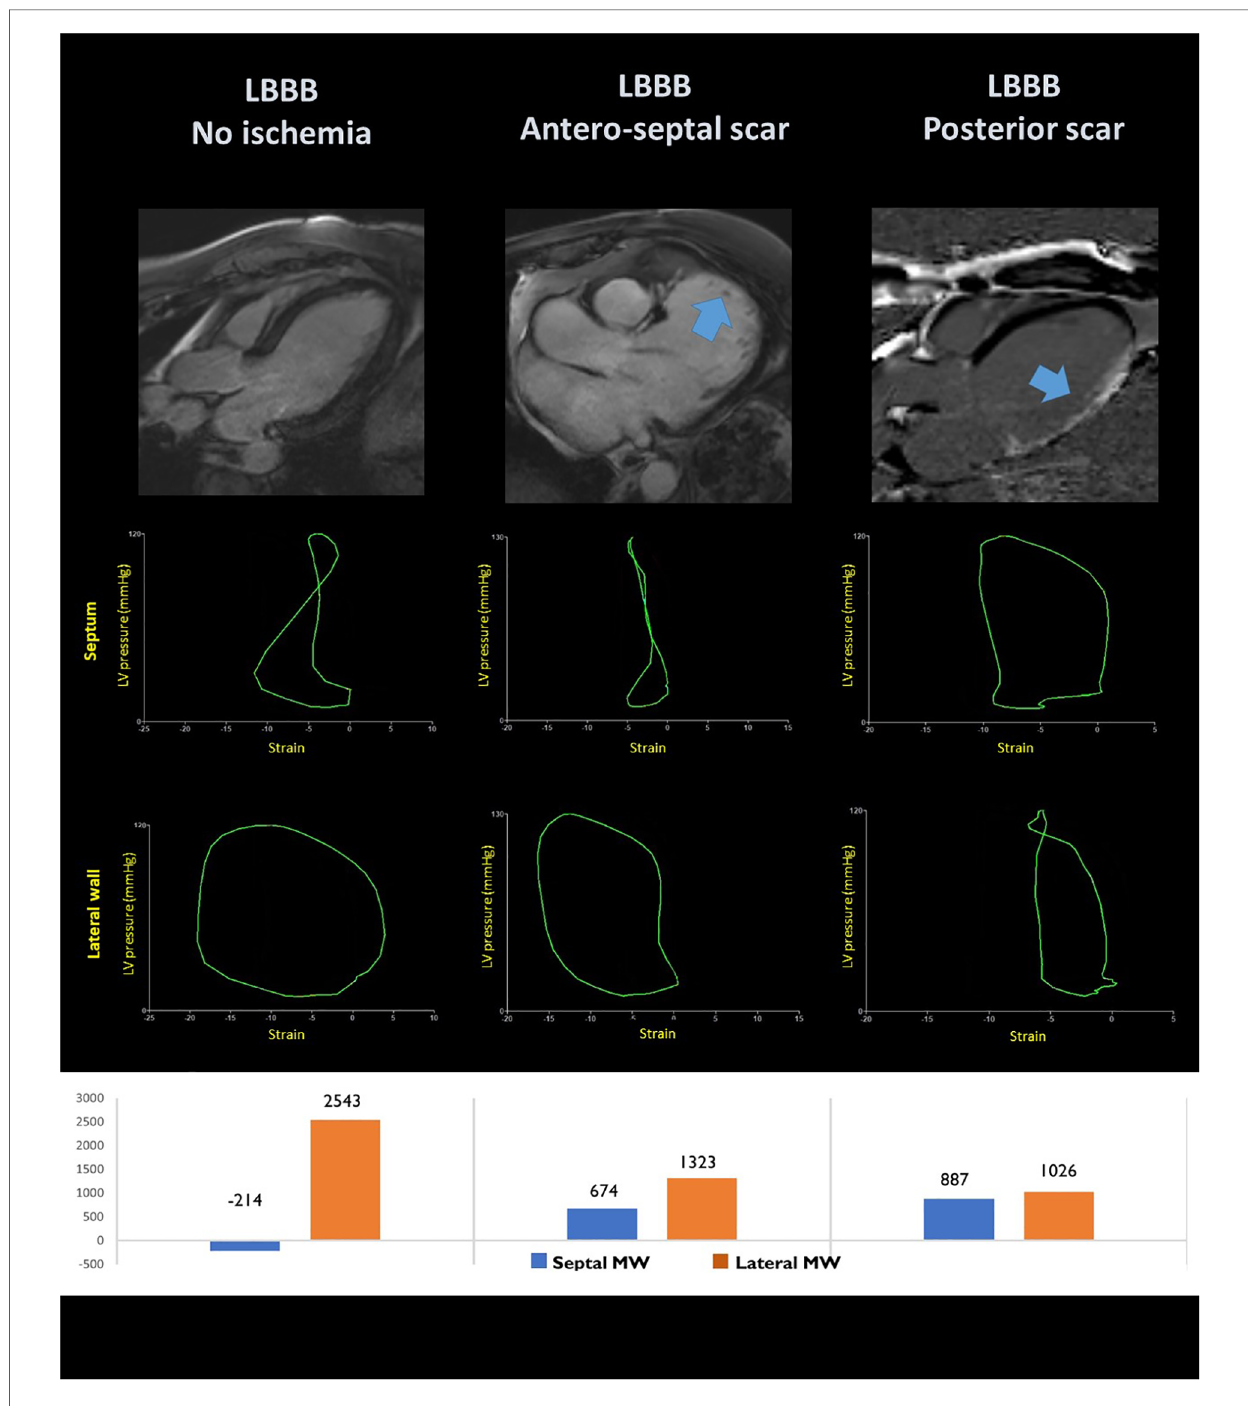
FIGURE 4 Pressure-loops analysis in the septal and lateral segments of patients with left bundle branch block without ischemic heart disease (left panel); with anteroseptal scar (central panel) and lateral wall scar (right panel). The corresponding localisation of the myocardial scar is shown at MRI late gadolinium enhancement in the upper